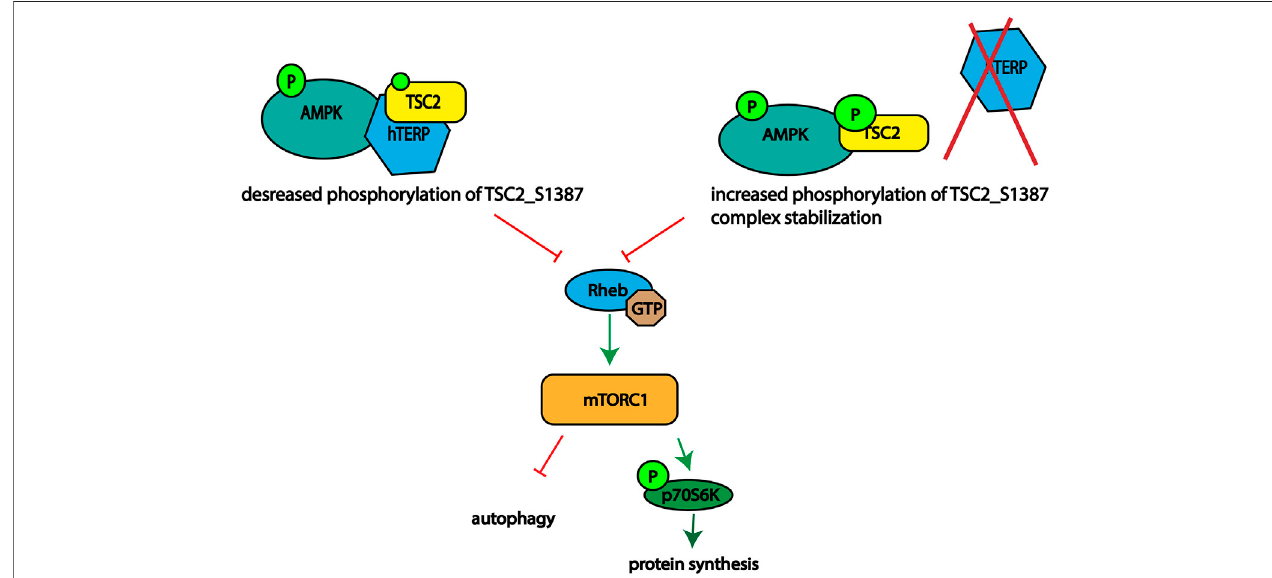
FIGURE 5 | Schematic illustrating the role of hTERP in the regulation of TSC2 phosphorylation at Ser1387 by AMPK.